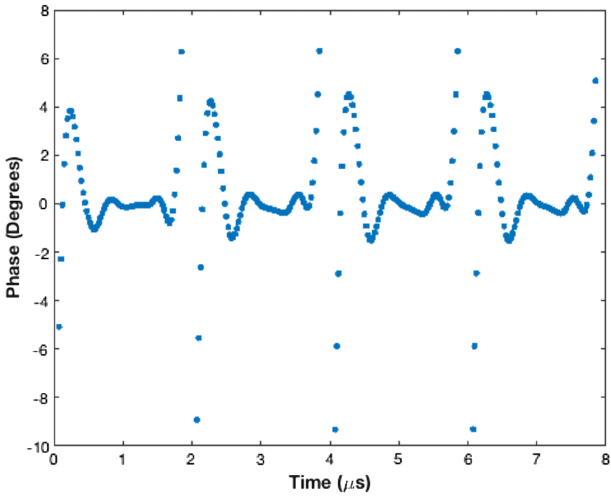
cavity.FIG. 23. Beam phase with baseline